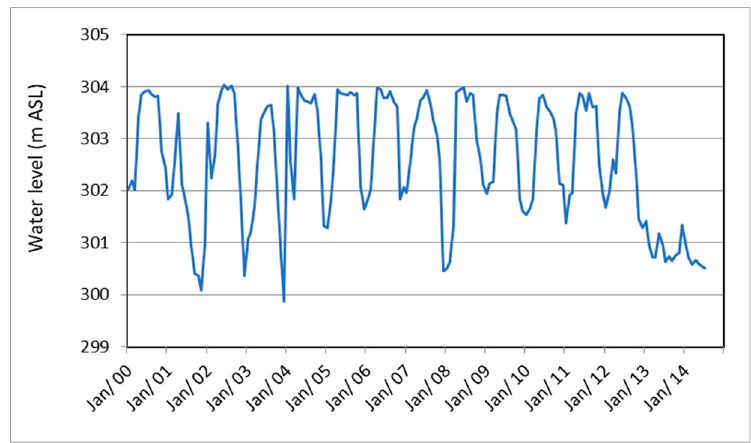
Figure 5. Upstream water level (meters above sea level, m a.s.l.) in the Itaparica Reservoir during the last years; a long-lasting drought period has occurred since 2013 [74].